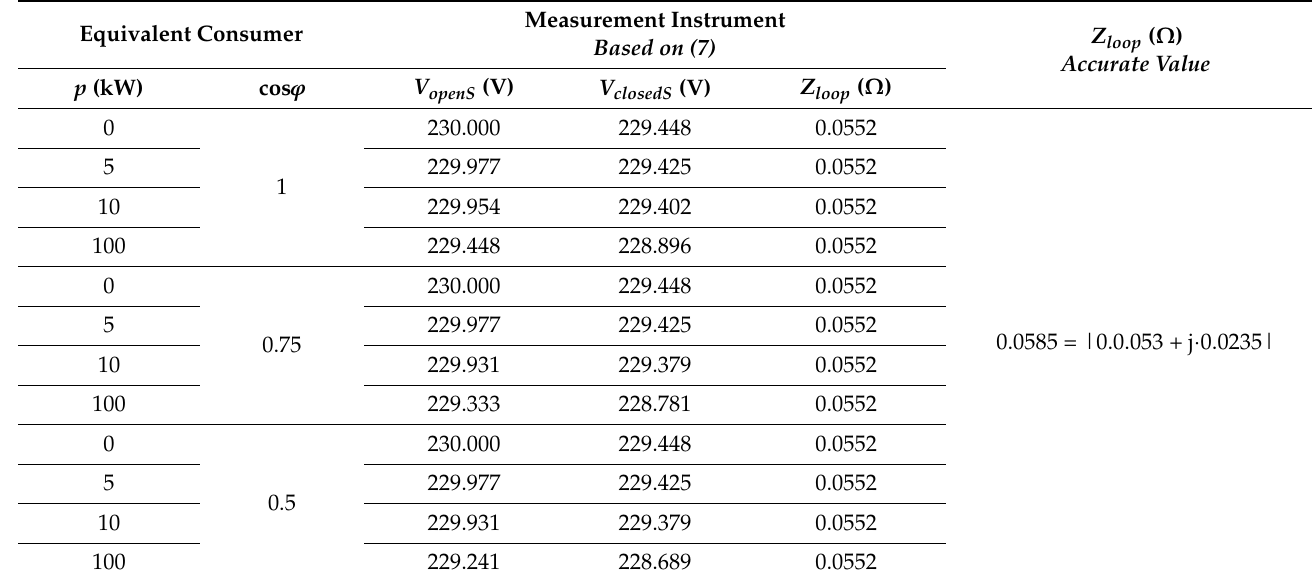
Table 7. The 400-kVA transformer and L = 10 m for cable